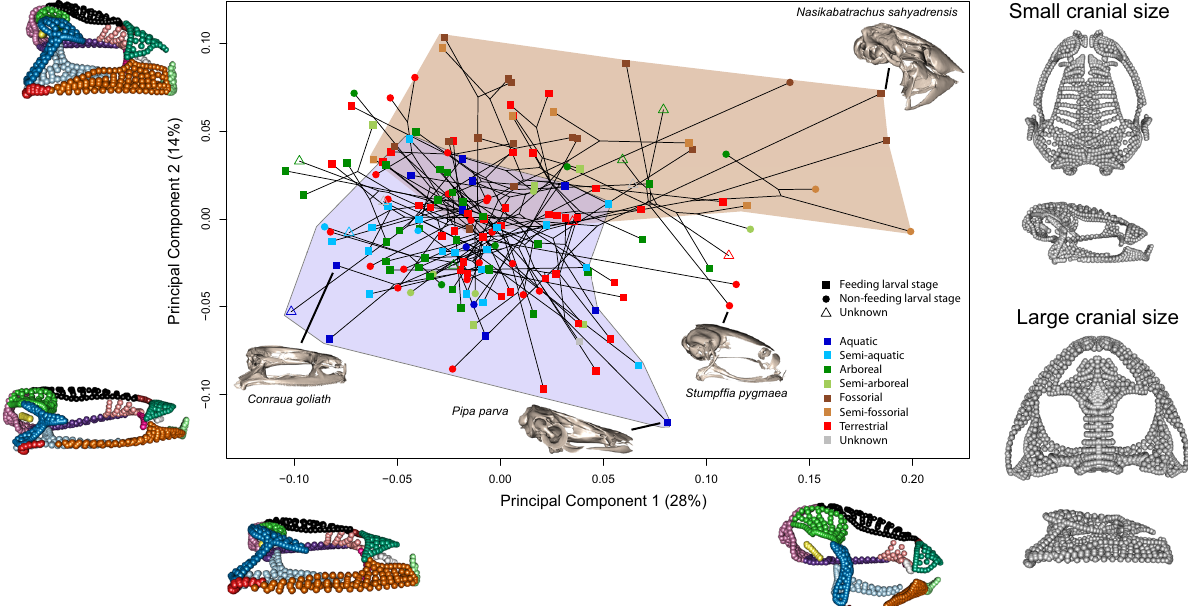
Fig. 2 Phylomorphospace of anuran skull variation. Each specimen ’ s location is coloured by microhabitat and the symbols indicate larval feeding. The maximum morphospace occupation for fossorial (including semi-fossorial) and aquatic (including semi-aquatic) species is illustrated by shading in the respective regions brown and blue. Specimen meshes are included to demonstrate the general shape differences between fossorial ( Nasikabatrachus sahyadrensis ) and aquatic ( Pipa parva ) species, as well as the specimens with the largest ( Conraua goliath ) and smallest ( Stumpf fi a pygmaea ) crania. Extreme shapes along both axes are visualised (in lateral aspect) by deforming the shape data along each axis and are coloured by cranial region (see Supplementary Fig. 1). Estimated cranial morphology at minimum and maximum cranial size is also presented, shown in dorsal (top) and lateral (bottom) aspects. Landmark data were mirrored for visualisation purposes